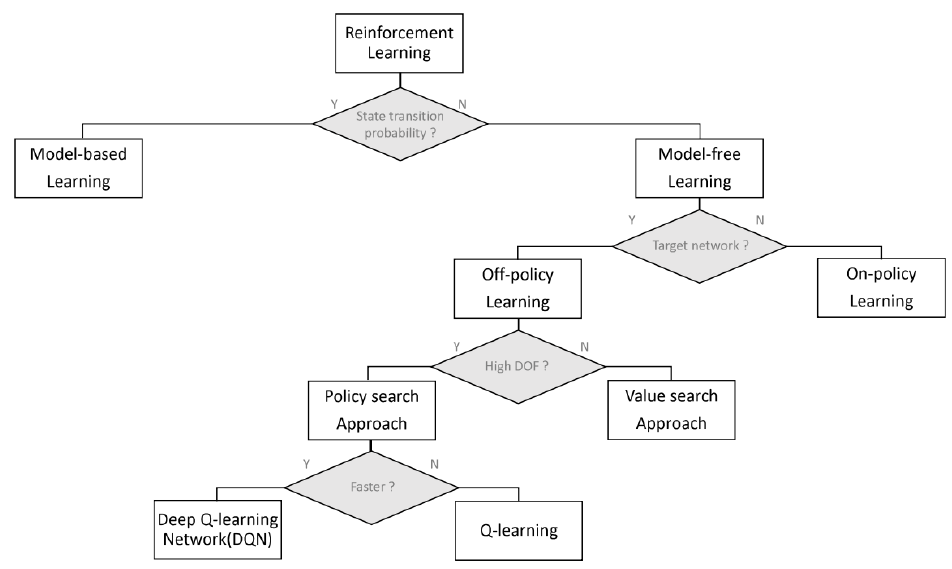
Figure 10. Classification of reinforcement learning approaches.